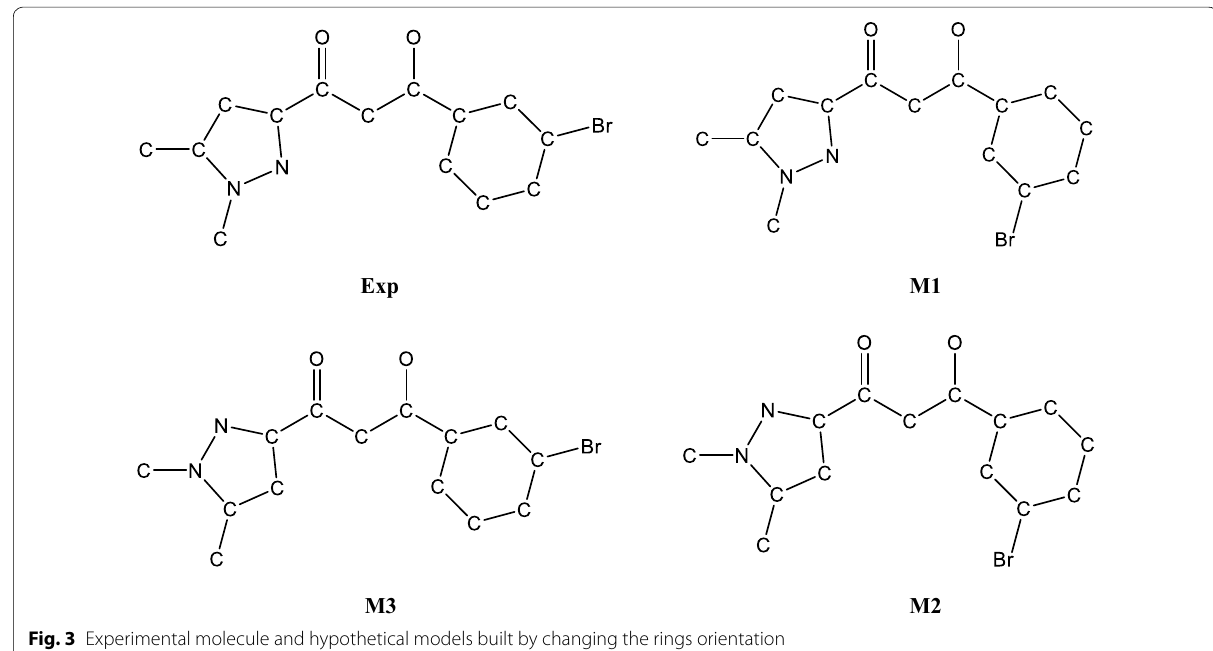
Fig. 3 Experimental molecule and hypothetical models built by changing the rings orientation